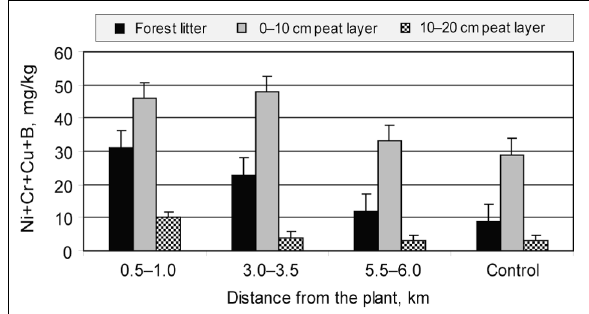
Fig. 4. Microelement (nickel, chromium, copper, boron) content in forest litter and peat soil in vicinity of “Akmenės cementas” Comparing to the results of our previous analysis (Stravinskienė, Kubertavičienė 2001, the results of this study indicates decreased amounts of microelements in % all observation plots. Significant (20–30 ) decrease of strontium, barium, titanium and manganese amounts was estimated in forest litter and upper 10 cm peat layer at observation plots I and II (till 3.5 km from the factory). At the farthest distance (5.5–6.0 km) the reduction of amounts is less and similar to the control.